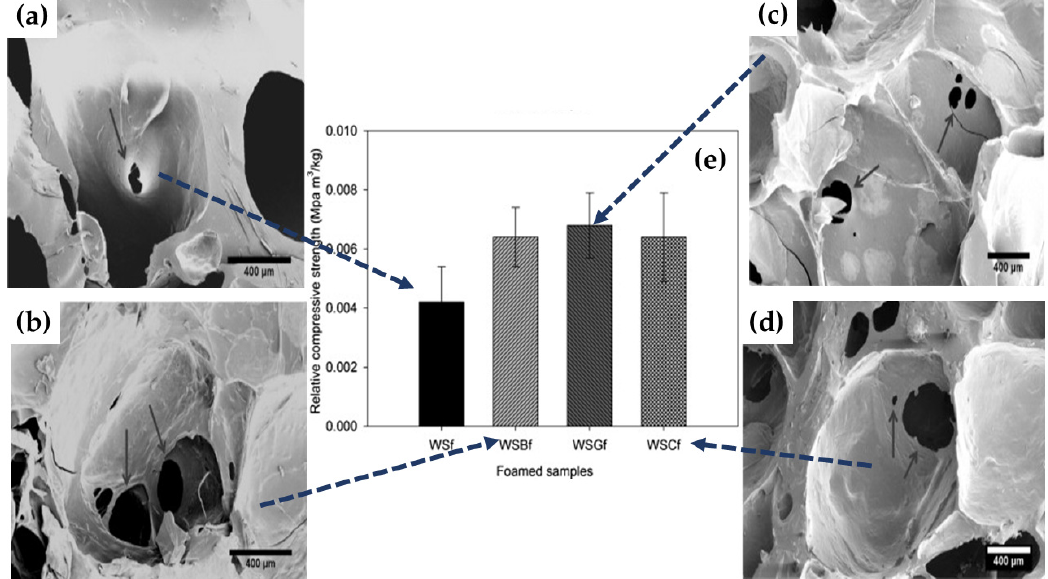
Figure 12. SEM micrographs of cells interconnected. ( a ) Wheat starch (WSf) (60x), wheat starch starch—grape—barley (WSBf) (60x) ( b ), ( c ) wheat starch—grape (WSGf) (40x), and ( d ) wheat starch— cardoon (WSCf) (40x). ( e ) Relative compressive strength of the foams produced. Reprinted with permission from the authors of [51]. Copyright © (2015) Elsevier.